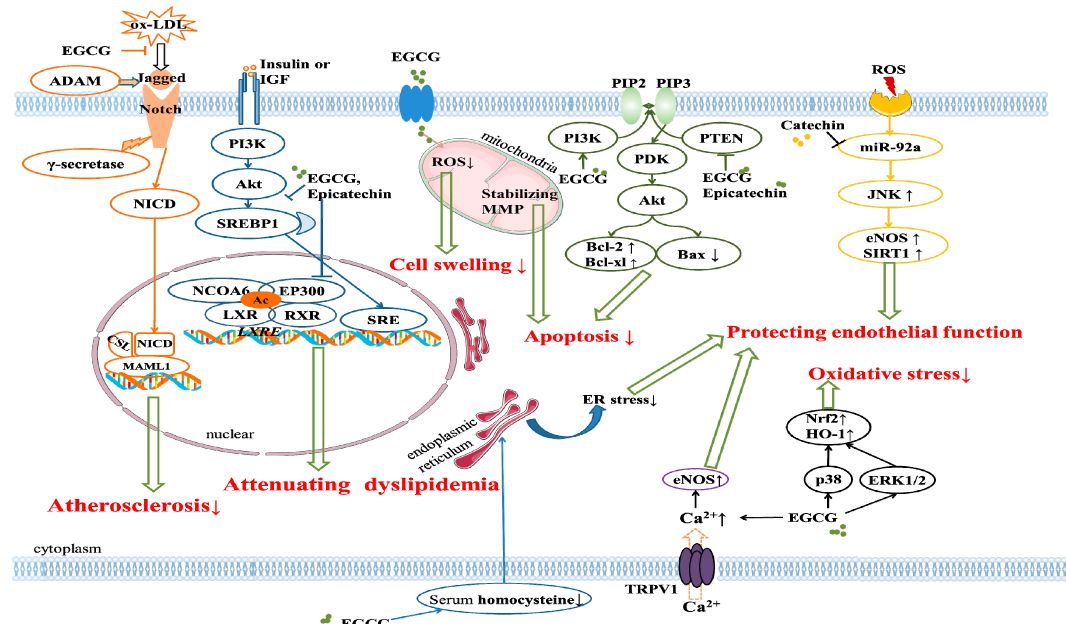
Figure 2. Signaling pathways involved in the protective effects of tea bioactive compounds against cardiovascular diseases. Epigallocatechin-3-gallate (EGCG) reduced atherosclerosis by inhibiting the activation of the Notch receptor induced by oxidized-LDL. EGCG and epicatechin could attenuate dyslipidemia through regulating the SREBP1 pathway. EGCG could reduce the reactive oxygen species level in mitochondria and stabilize the mitochondrial membrane potential, thus attenuating cell swelling and apoptosis of endothelial cells. EGCG and epicatechin could reduce the apoptosis of cardiac cells through regulating the PI3K pathway. EGCG could protect endothelial function through alleviating endoplasmic reticulum stress. EGCG and catechin could elevate the endothelial nitric oxide synthase (eNOS), thus protecting endothelial function. EGCG could reduce oxidative stress by regulating the p38 MAPK and ERK1/2 pathways. Abbreviations: ADAM, A-Disintegrin-And-Metalloprotease; NICD, Notch intracellular domain; PI3K, phosphatidylinositol-3-kinase; Akt, α serine/threonine-protein kinase; SREBP, sterol regulatory element binding transcription factor; LXR, liver X receptor; RXR, retinoid X receptor; NCOA6, nuclear receptor coactivator 6; PTEN, phosphatase and tensin homolog; PDK, phosphoinositide dependent kinase; Nrf, nuclear factor E2-related factor; HO-1, heme oxygenase-1; TRPV, transient receptor potential vanilloid type.